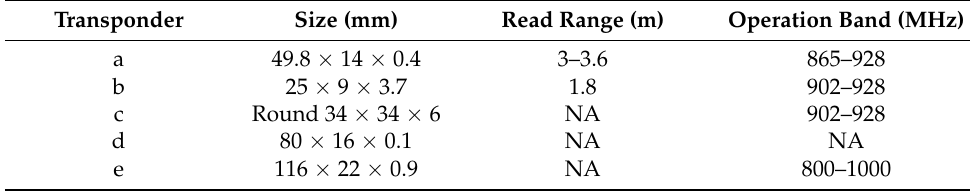
Table 2. Specifications of selected transponders.